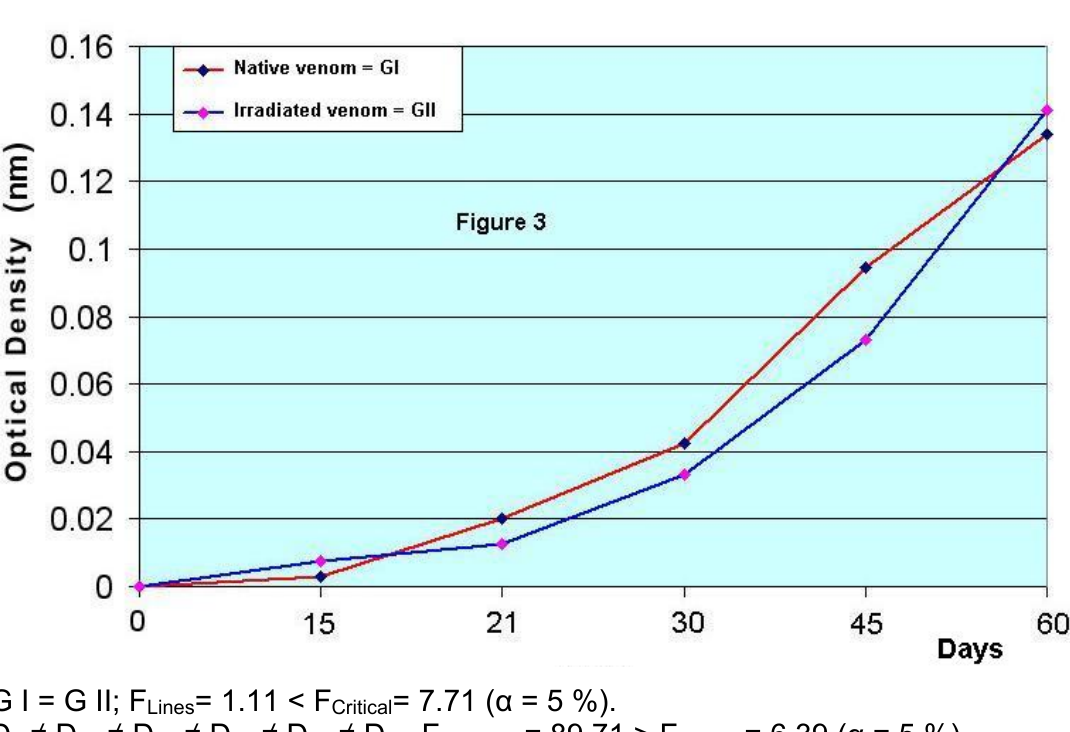
G I = G II; F = 2.04 < F = 7.71 ( α = 5 %). Lines Critical D ≠ D ≠ D ≠ D ≠ D ≠ D F 0 15 21 30 45 60; Columns